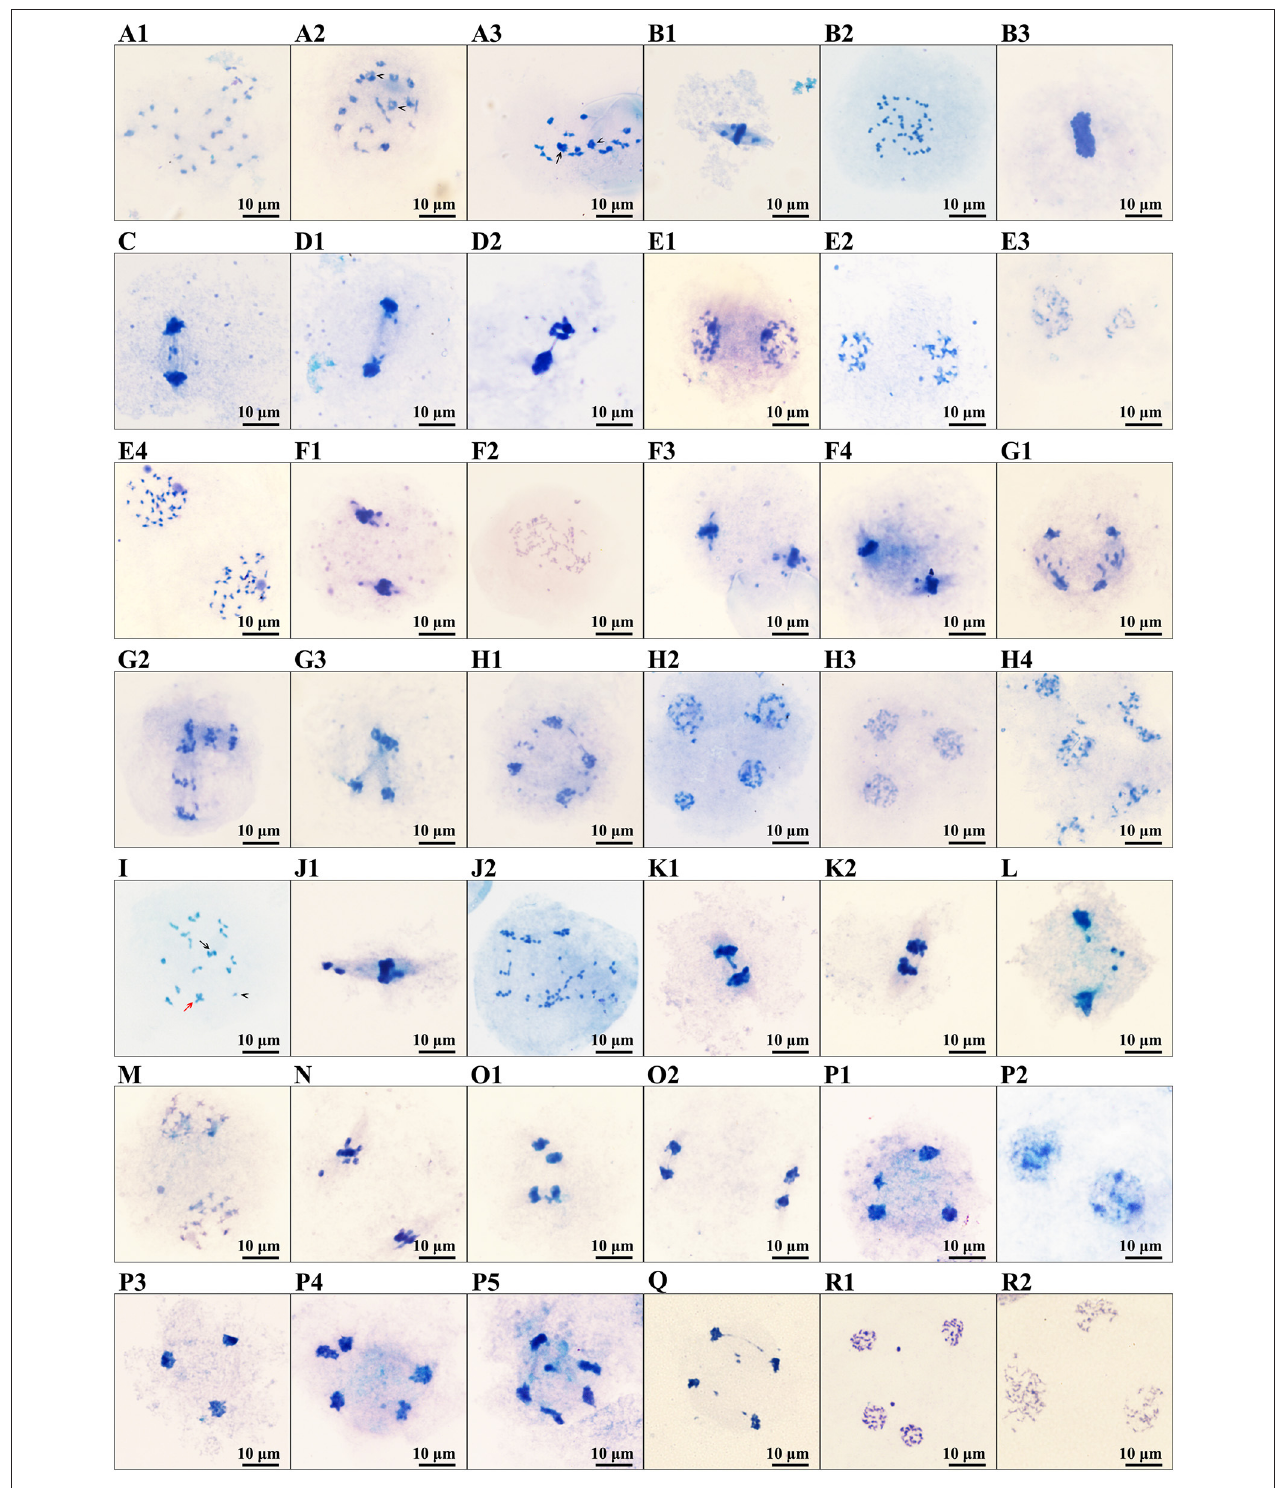
FIGURE 5 | Images of abnormal phenomena of PMCs meiosis: (A1–H4) , images of PMCs meiosis of H30-6: (A1–A3) , diakinesis, (A1) showing the univalent, (A2) showing the trivalent, (A3) showing the quadrivalent (arrowhead) and pentavalent (arrow); (B1–B3) , metaphase I, (B1) showing a chromosomes lag, (B2,B3) showing doubled chromosomes; (C) showing chromosomes lag and micronucleus in anaphase I; (D1,D2) , Telophase I, showing chromosomes lag, micronucleus